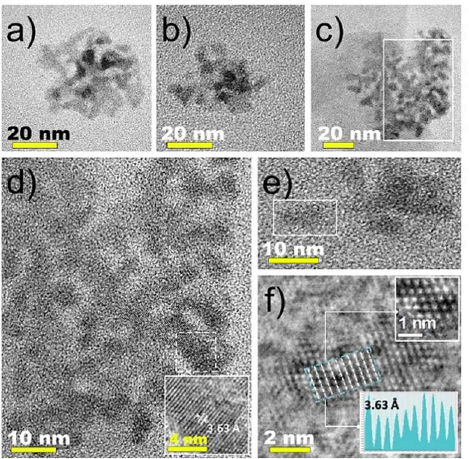
Figure 4. ( a ) STEM micrograph of the Pt 2 NiCo / C catalyst after the accelerated stability test. ( b , c ) Agglomerates constituted by nanoparticles of the Pt 2 NiCo / C catalyst. ( d ) Magnified view of the framed zone in ( c ). ( e ) The framed zone reveals the presence of an isolated, elongated and rounded nanoparticle, as well as the occurrence of a small agglomerate. ( f ) Magnified view of the framed zone in ( e .